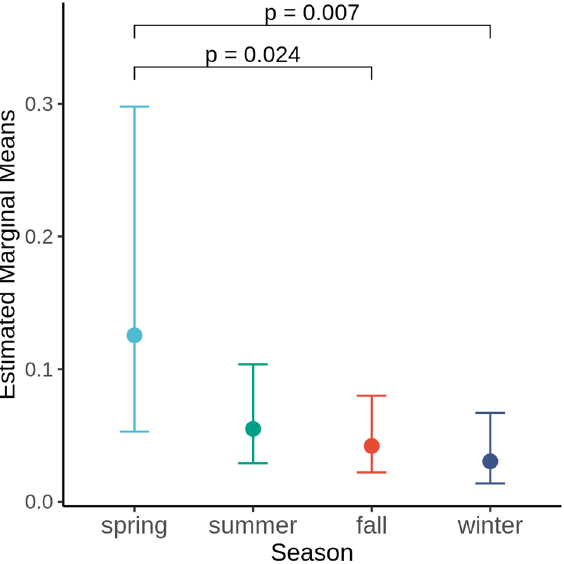
Figure 5. Results of a GLMM comparing the frequency of anti- Pd isolates collected from bats sampled during different seasons. Sampling location was included as a random factor, and the p values from the multiple comparison test of estimated marginal means for each season were adjusted based on Sidak correction.